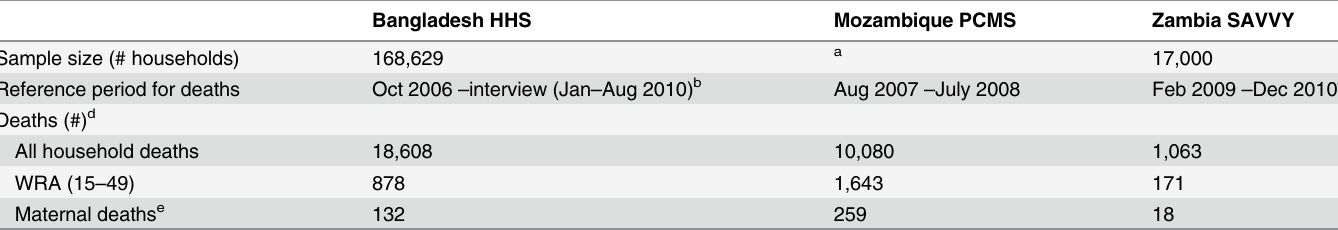
Table 1. Comparison of sample characteristics (unweighted).